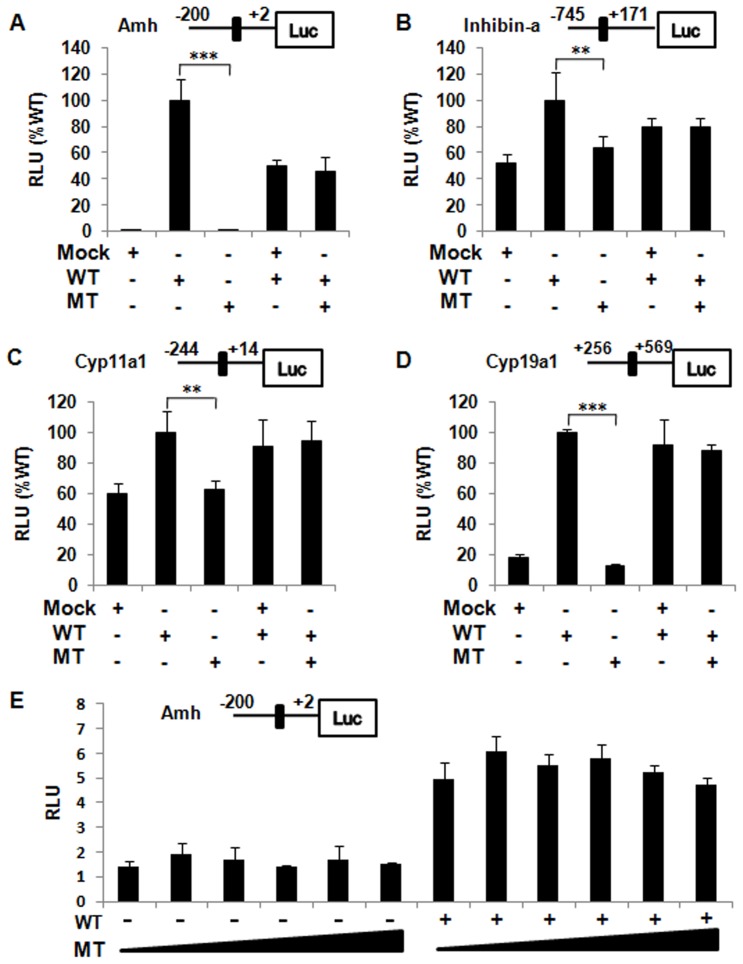
Transactivation activity assay.Co-transfection of empty (Mock), wild-type (WT), or mutant (MT) Sf1 expression vectors and a Amh (A), Inhibin-a (B), Cyp11a1 (C) or Cyp19a1 (D) promoter reporter were performed in HEK293T cells. Results are expressed as a percentage of WT activity (RLU WT%). The potential dominant negative effect of the p.Y5D mutant was assessed by co-transfecting WT expression vector with empty or MT vector (1∶1) (A, B, C, D) and increasing MT (0, 10, 20, 30, 40 ng) with 10 ng empty (−) or 10 ng WT (+) vector (Amh only) (E) in HEK293T cells. ** P<0.01, *** P<0.001. RLU, relative light units.